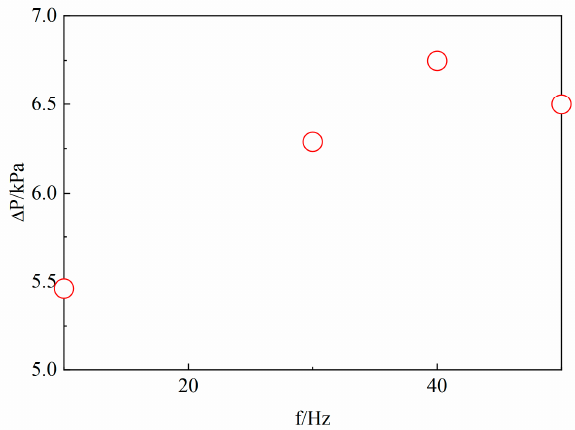
Figure 22. The channel inlet and outlet pressure drop changes with the diaphragm frequency ( x = 28.5 mm).